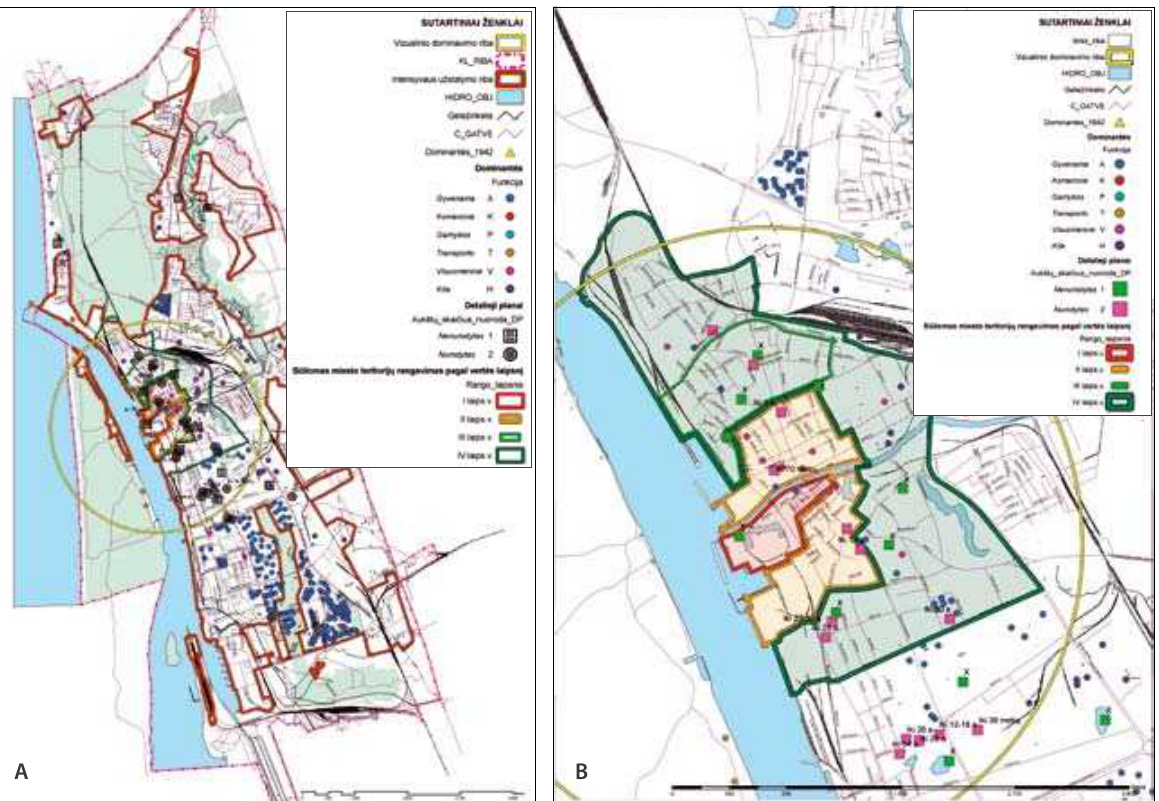
Fig. 3. High-rise building location in the city and evaluation of planning documents which are valid in municipality’s territory have an influence on townscape formation: A – on a city scale; b – on a central-part